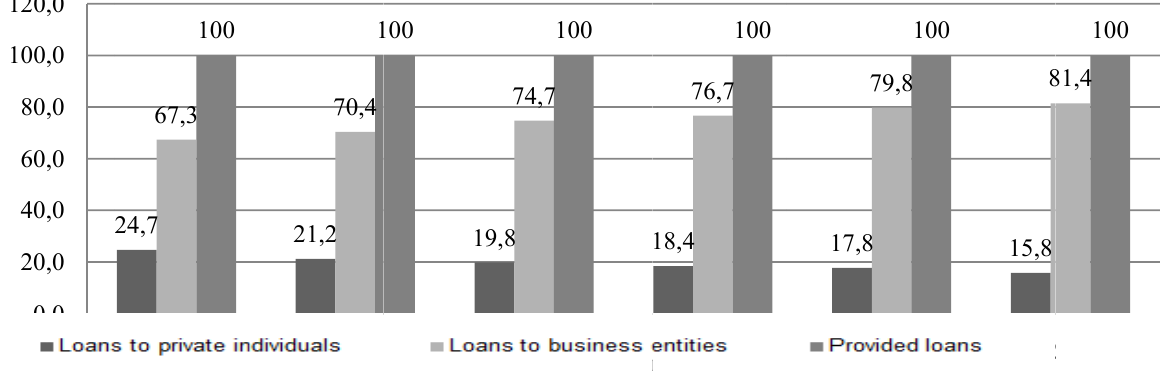
Кредити , над the share of l ntinuously. T f loans to pr ntage points y the bank uation is und ciated with l strong sup nificant reduc dence of its in